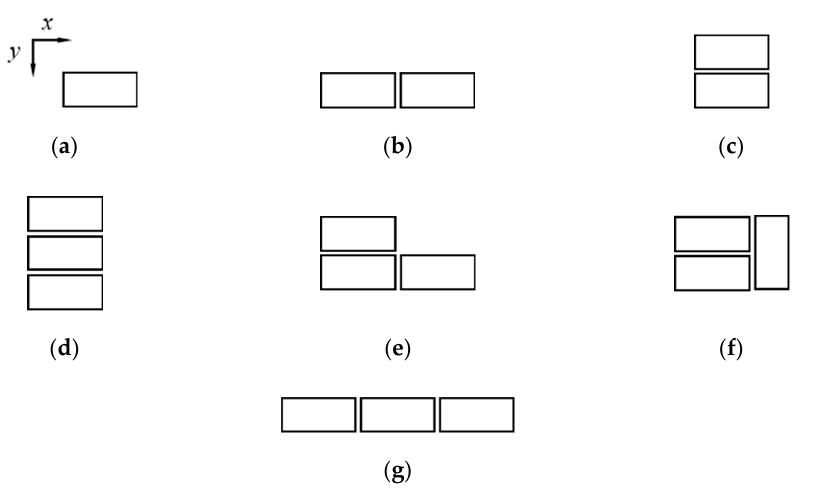
Figure 3. Schemes of horizontal assembly: ( a – g ) scheme 1 to 7.